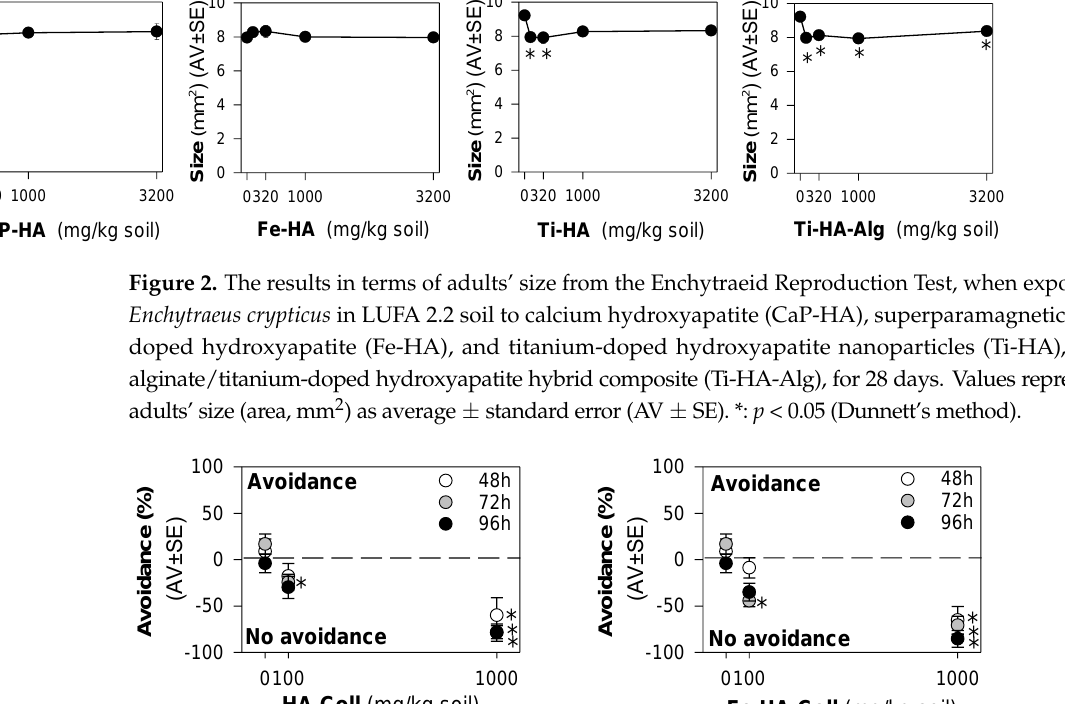
Figure 3. The results in terms of avoidance behavior from the avoidance test when exposing Enchytraeus crypticus in LUFA 2.2 soil, during 48 (standard), 72, and 96 h to collagen/hydroxyapatite hybrid scaffold (HA-Coll) and collagen/iron-doped hydroxyapatite hybrid scaffold (Fe-HA-Coll). Values represent average ± standard error (AV ± SE). *: p < 0.05 (Dunnett ’ s method).